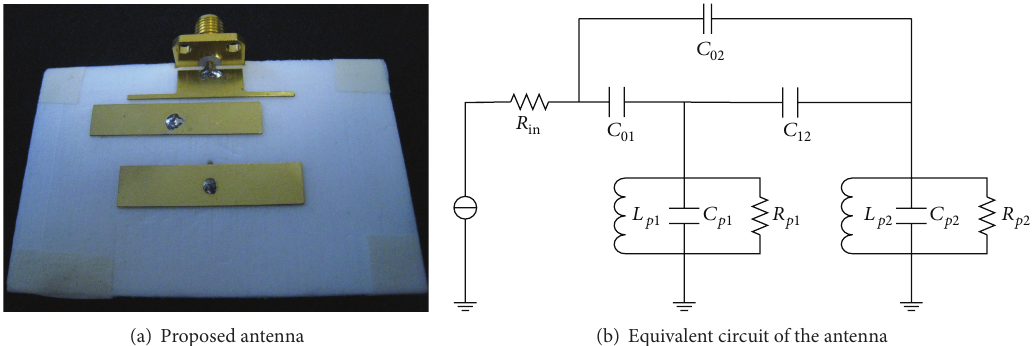
Figure 8: 2nd order proposed antenna and its equivalent circuit. Dimension: 35 mm × 23mm × 3 mm ( 𝜆 0 /3.5 × 𝜆 0 /5 × 𝜆 0 /40 ).